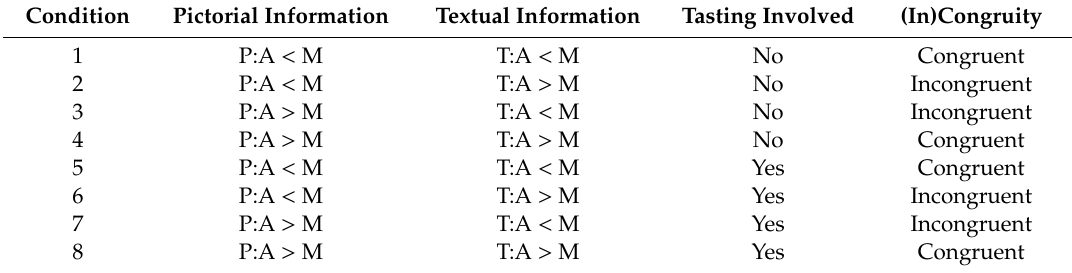
Table 1. Overview of the 2 (pictorial) × 2 (textual) × 2 (tasting) experimental conditions. A < M refers to either the picture (P) or the text (T), representing less apple than mango; and A > M more apple than